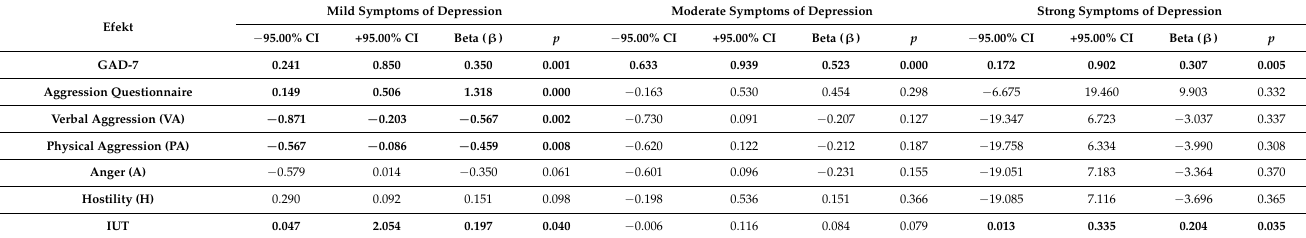
Table 4. Multivariate linear regressions in the Beck Depression